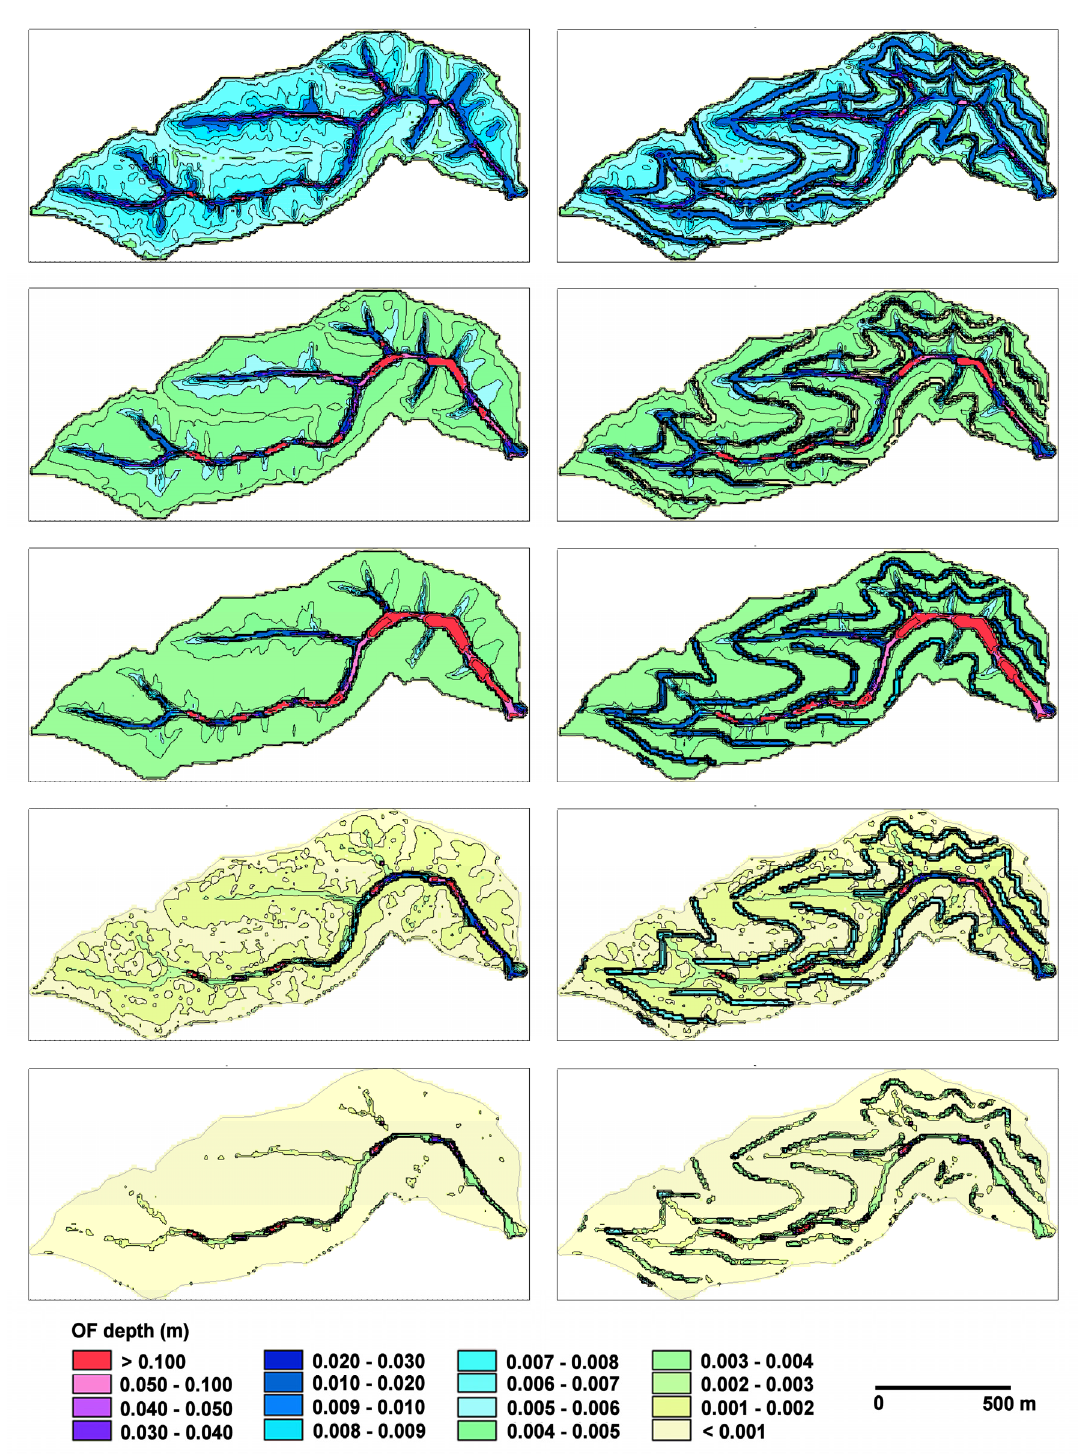
Figure 7. A time-series OF for pasture ( left ) and IVB ( right ) models. The time-steps are in series from top to bottom showing changes in overland flow every 24 h beginning at 4:15 pm 7 February 1999. The major changes are increased flow depth in IVB themselves, as well as a broader spatial distribution and longer duration of flow in the IVB